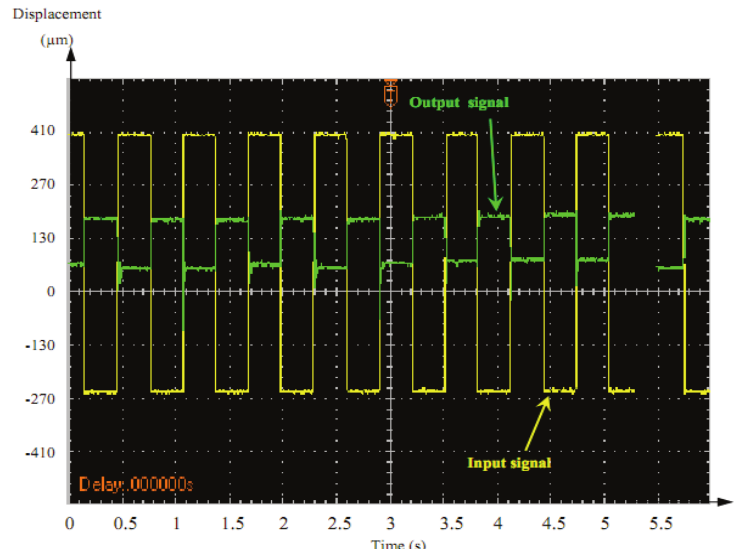
Figure 16. Square-wave